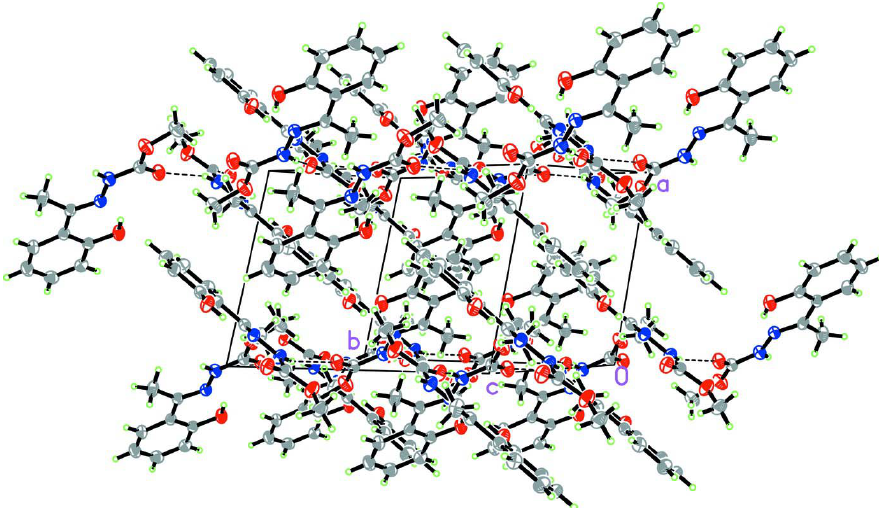
Crystal packing of the title compound. Dashed lines indicate intermolecular hydrogen